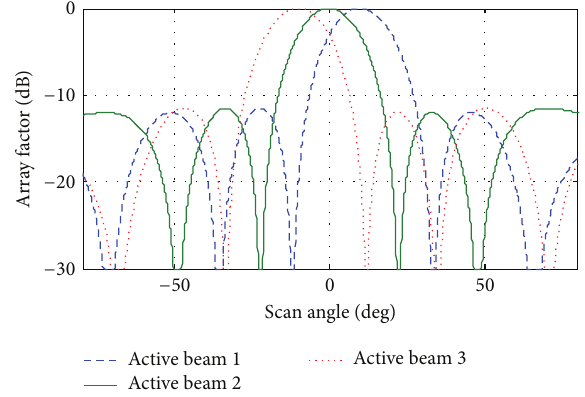
Figure 3: Array factor for three input ports excited